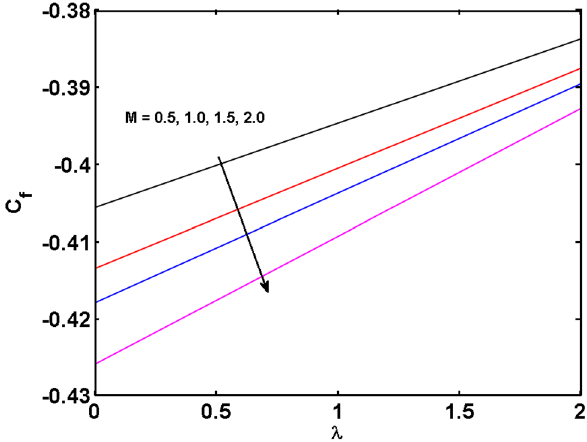
Figure 17. C F for various of estimates of M and (cid:31) .